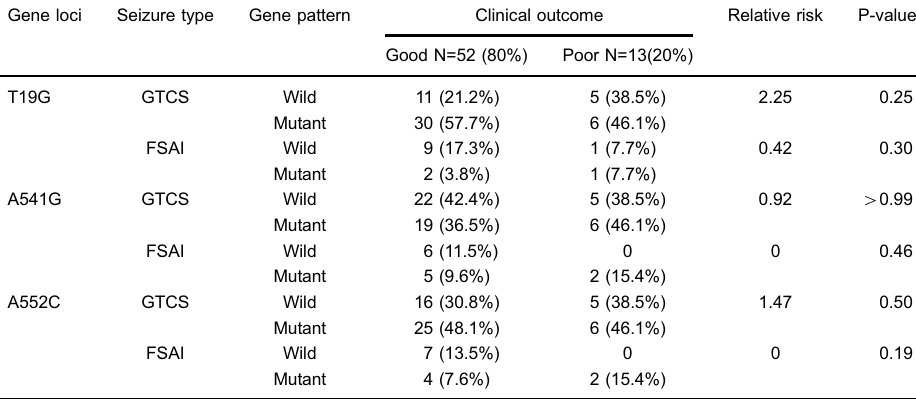
Table 4. Relative risk of poor clinical outcome in various types of seizures. Gene